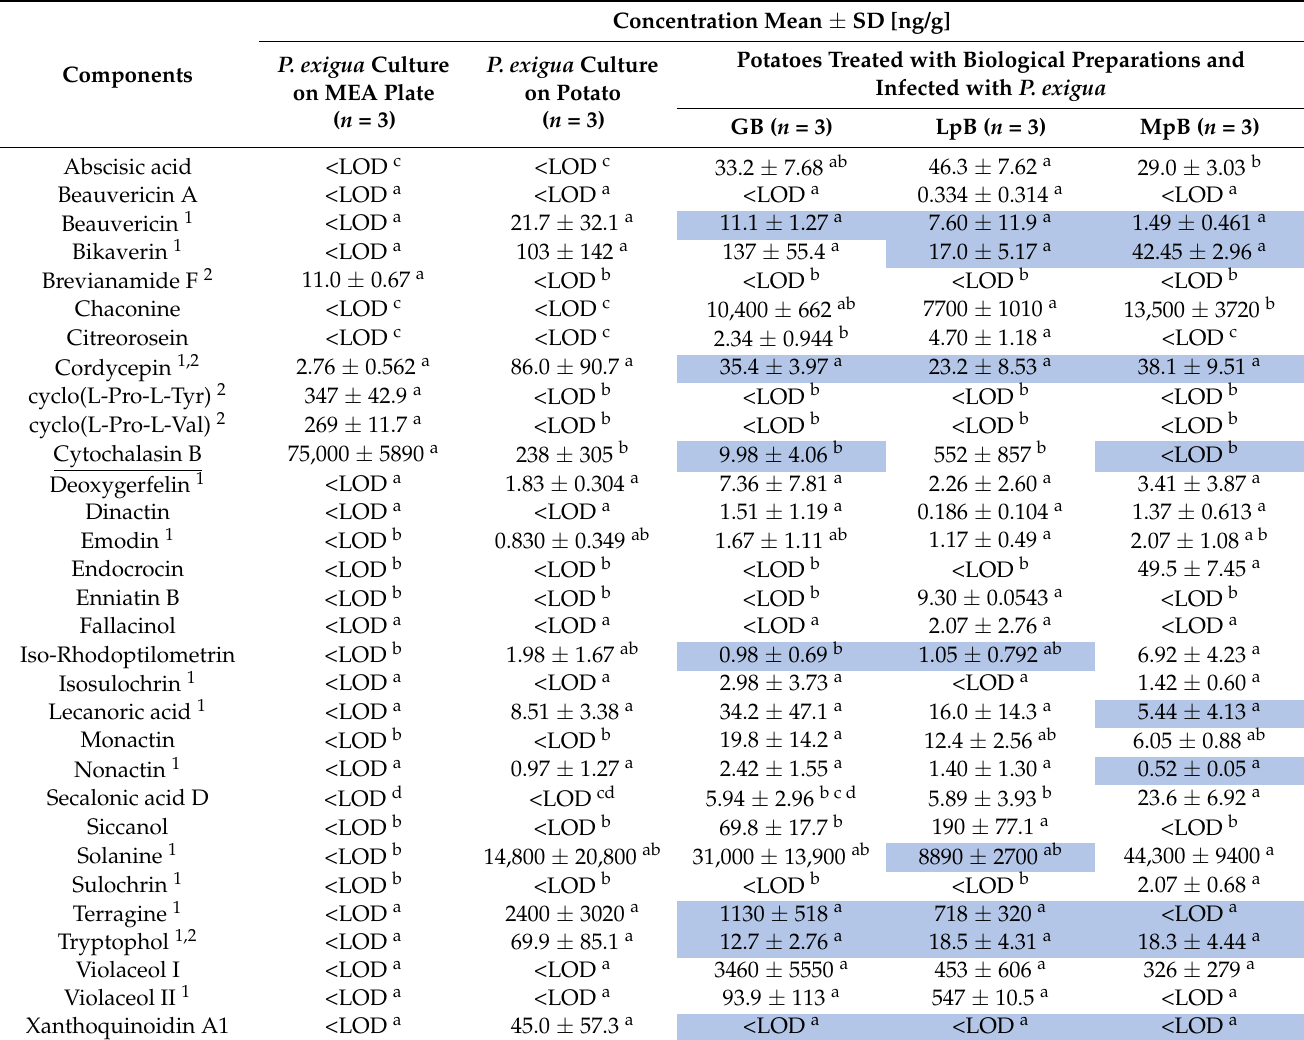
Table 4. Secondary metabolites of Phoma exigua growing on MEA plates and potatoes treated with